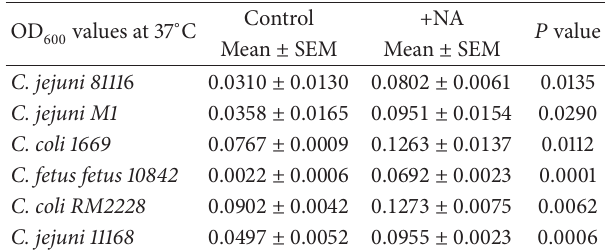
Table 1: The OD values at the start of stationary phase of growth 600 in the presence and absence of NA at 37 ∘ C. The mean ± SEM of three experiments was compared using an unpaired 𝑡 -test and the significance values ( 𝑃 value) are